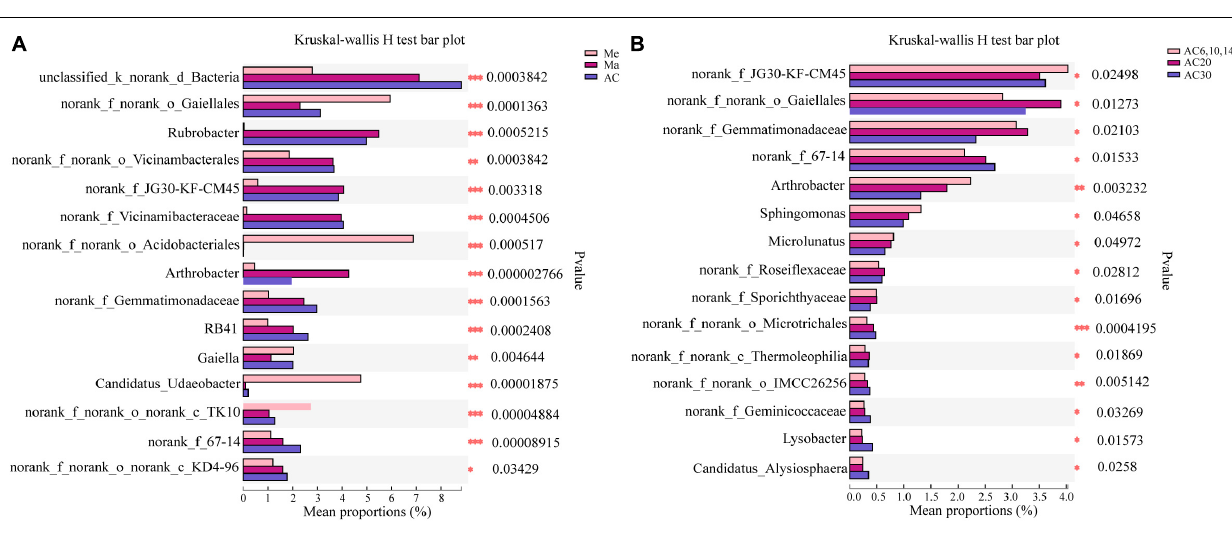
FIGURE 5 | Effect of crop type (A) and continuous cropping years (B) on the differentiation of bacterial